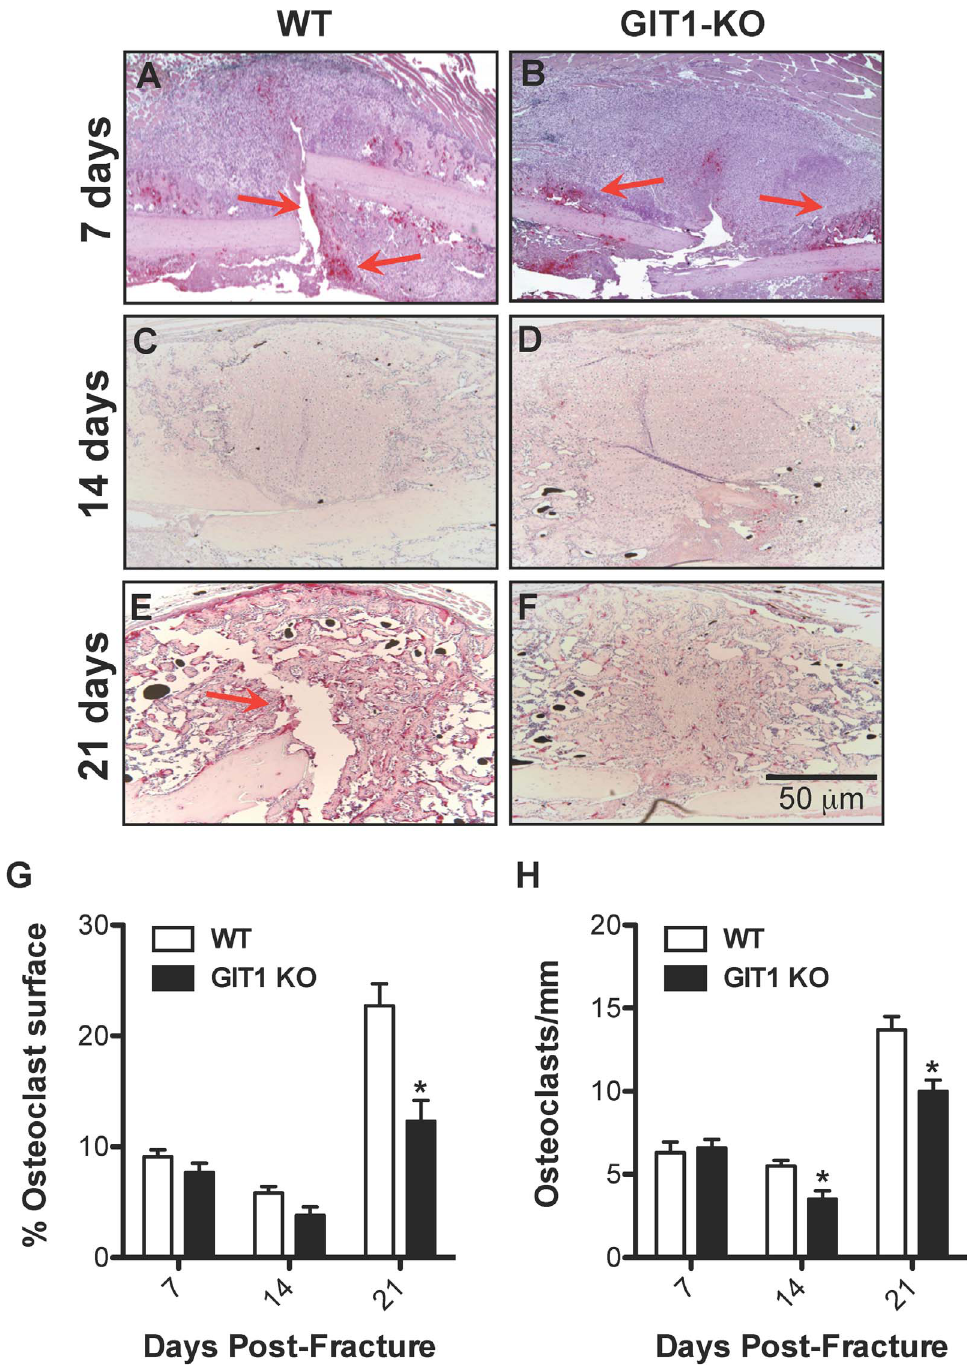
Figure 10. Osteoclast number is reduced in GIT1 KO mice. The presence of osteoclasts in the fracture callus of WT and GIT1 KO mice was assessed at 7 (A and B respectively), 14 (C and D respectively) and 21 days (E and F respectively) post-fracture via TRAP staining. Histomorphometry to quantify percentage of osteoclast surface (G) and osteoclast number per unit bone surface (H) was also performed on triplicate sections from multiple mice, with bars representing the mean for each parameter + / 2 SEM (*p , 0.05,